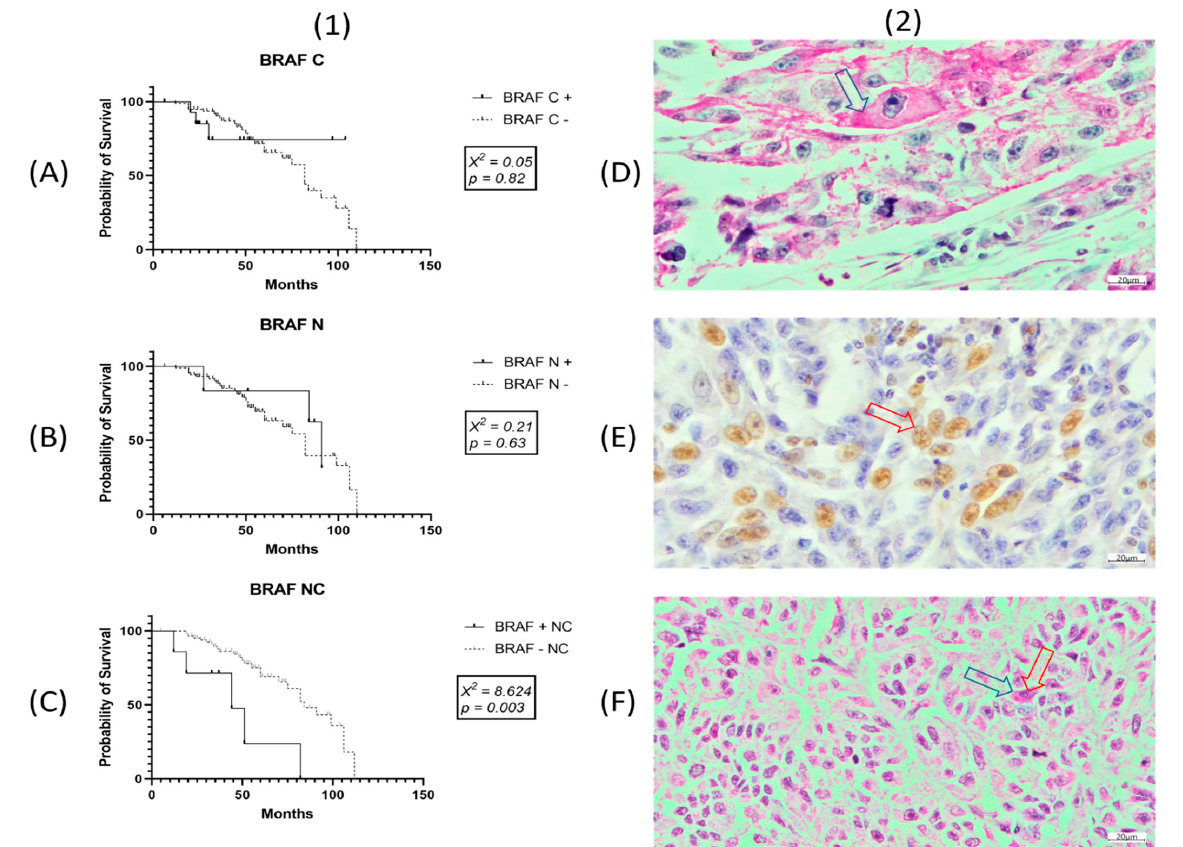
Figure 4. ( 1 ) Univariate Kaplan–Meier survival analysis shows independent prognostic value for mixed (cytoplasmic—C and nuclear—N) BRAF positivity ( C ), and not for nuclear ( B ) or cytoplasmatic ( A ) expression alone. ( 2 ) Representative pictures for immunohistochemistry expression of BRAF subcellular localization (20 μ m): ( D ) cytoplasm only seen in red with magenta, ( E ) nuclear only marked in brown with DAB, and ( F ) mixed positivity highlighted in red with magenta (red arrow—nuclear positivity, blue arrow—cytoplasmic positivity).